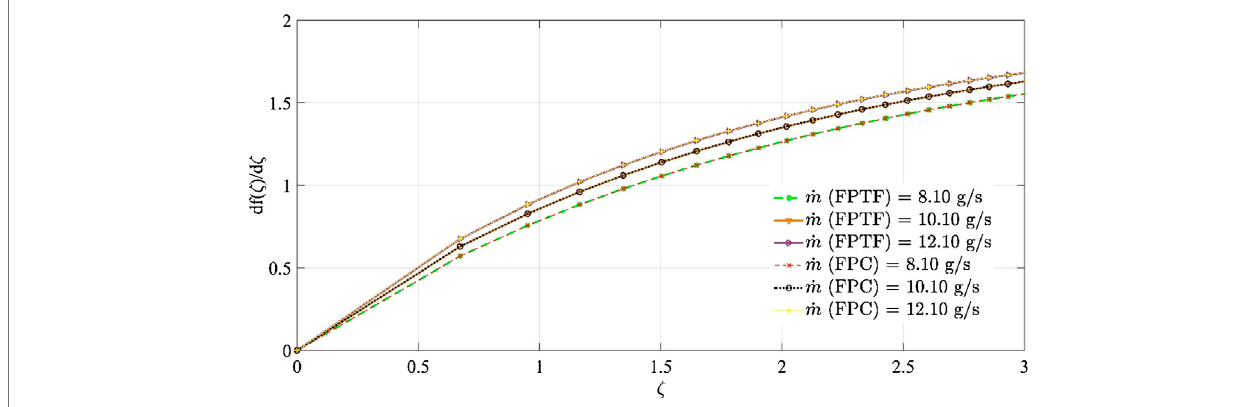
(cid:1)(cid:1) (cid:3) ) . U 0 vx